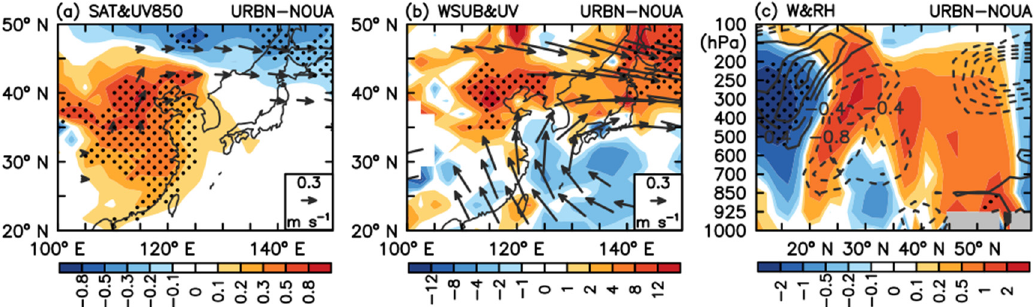
Figure 4. NDJ-mean changes in ( a ) SAT (color shading, in K ) and 850 hPa horizontal winds (vectors, in m/s) and ( b ) sub-grid vertical velocity (color shading, in 10 − 3 m/s) averaged over 1000–700 hPa and horizontal winds (vectors, in m/s) averaged over 500–200 hPa in East Asia due to the urban forcing alone (i.e., URBN − NOUA). ( c ) The vertical distribution of NDJ-mean changes in vertical velocity ( ω ; color shading, in hPa/day) and relative humidity (RH; contours, at an interval of 0.4%; dashed contours are for negative values and the zero contour is omitted for clarity) averaged over 105°–140° E due to the urban forcing. The stippling and vectors indicate the changes are statistically significant at the 90% confidence level based on the MC test.